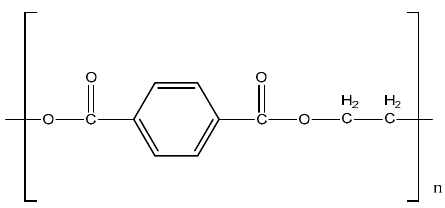
Figure 2. The structure of poly (ethylene terephthalate) (PET) .